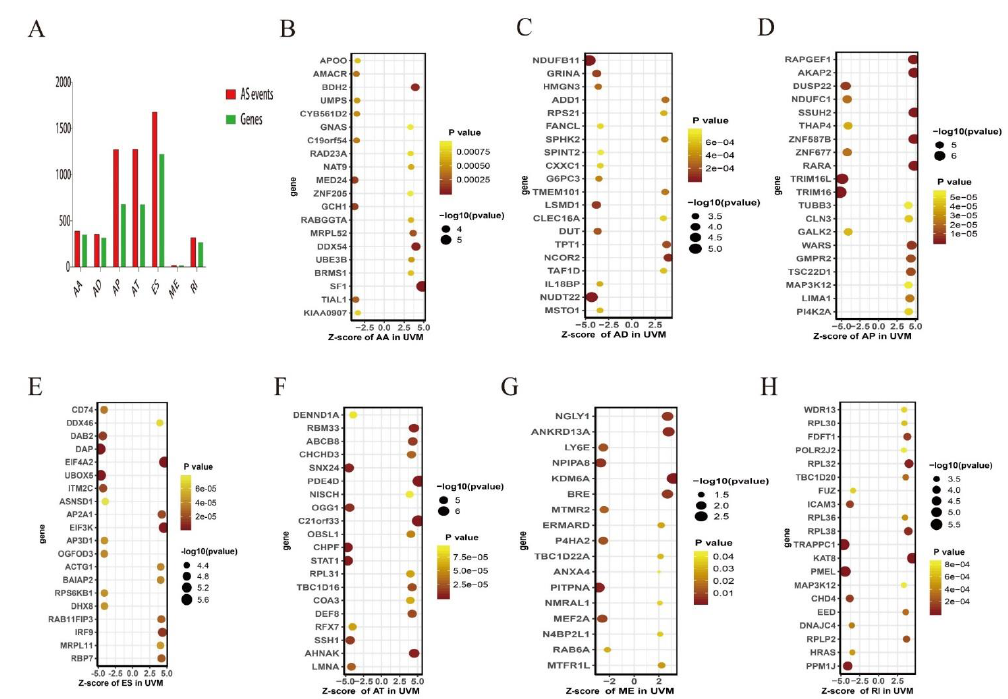
Figure 2. The 20 most significant AS events in UM. ( A ) The number of survival-related AS events and corresponding genes obtained by using univariable cox regression analysis. The x-axis stands for the types of alternative splicing, and the y-axis stands for the number of genes and AS events. ( B–H ) Forest plots of the top 20 significantly survival-related AS events for acceptor sites, the x-axis stands for z-scores, and the y-axis stands for survival-related AS events: ( B ) AA, alternate acceptors; ( C ) AD, alternate donors; ( D ) AP, alternate promoters; ( E ) ES, exon skip; ( F ) AT, alternate terminators; ( G ) ME, mutually exclusive exons; ( H ) RI, retained introns.